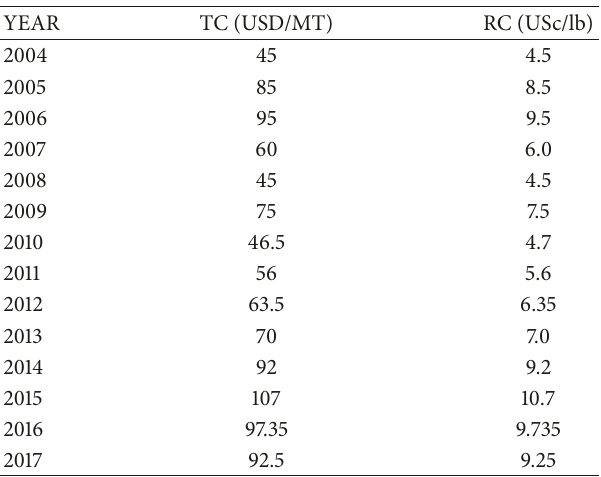
Table 2: TC/RC year benchmark levels (Data available free of charge. Source: Johansson [50], Svante [51], Teck [52], Shaw [53], Willbrandt and Faust [54, 55], Aurubis AG [56], Drouven and